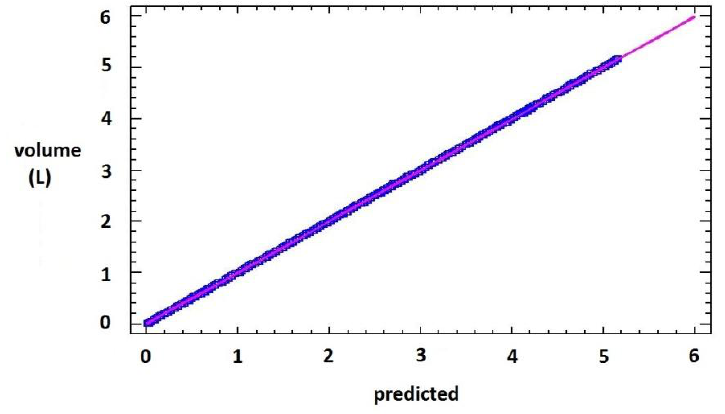
Figure 4. Output volume in L vs. predicted volume by the calibration curve